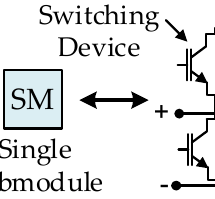
( c ) RPC based on half-bridge MMC.